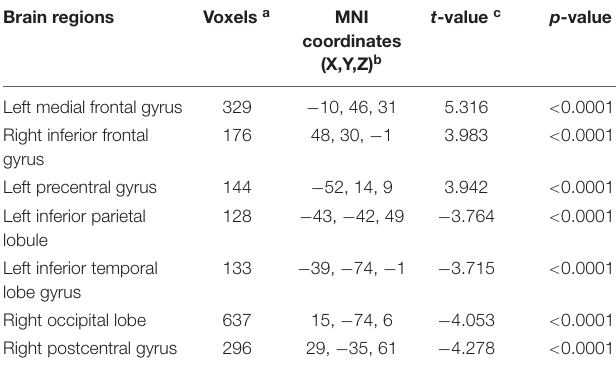
TABLE 1 | Demographic and clinical data of PD patients and healthy controls. TABLE 2 | Brain regions with abnormal DC in PD